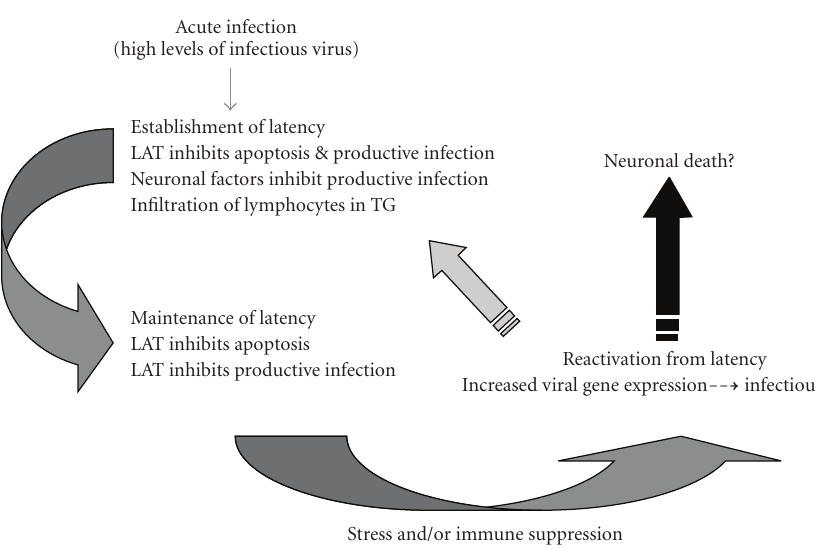
Figure 1: Steps in the latency-reactivation cycle of HSV-1. For details, see the